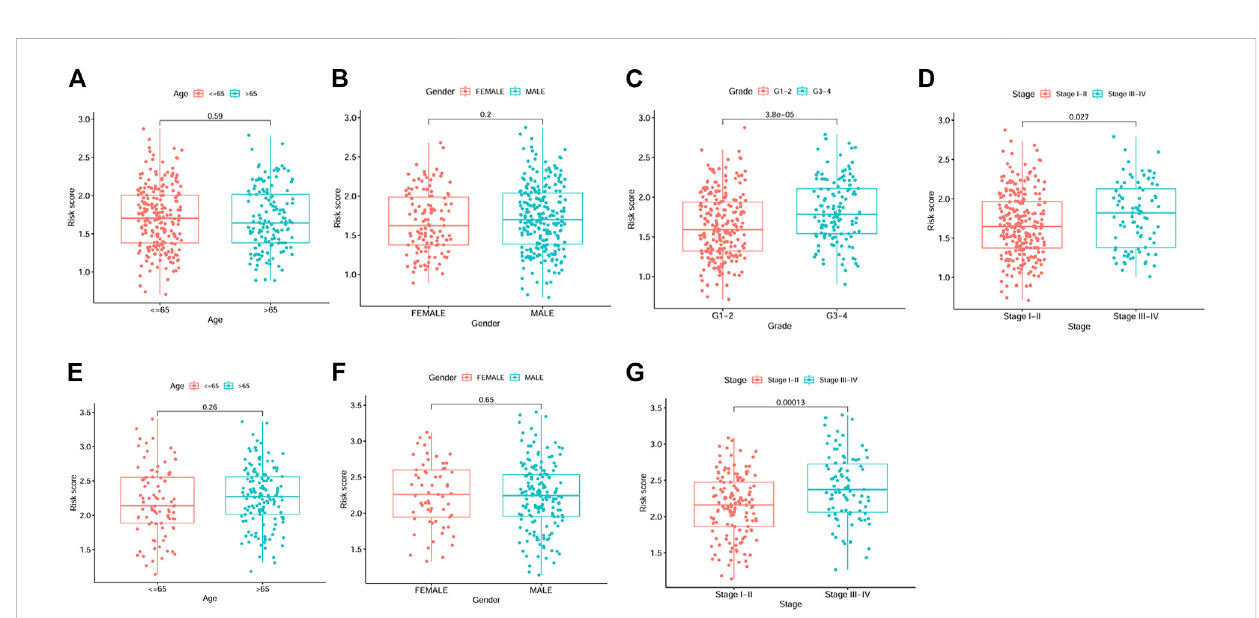
FIGURE 5 Box plots showing the correlations between risk score and clinicopathological factors. (A – D) Age, gender, grade and stage from TCGA dataset. (E – G) Age, gender and stage from ICGC